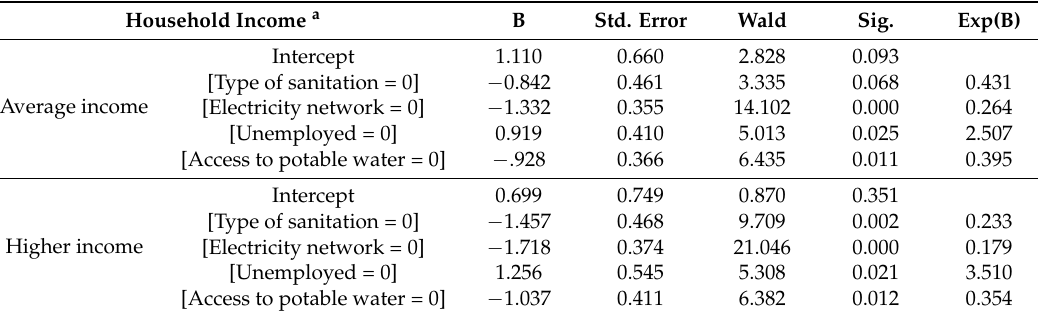
Table 8. Multinomial model